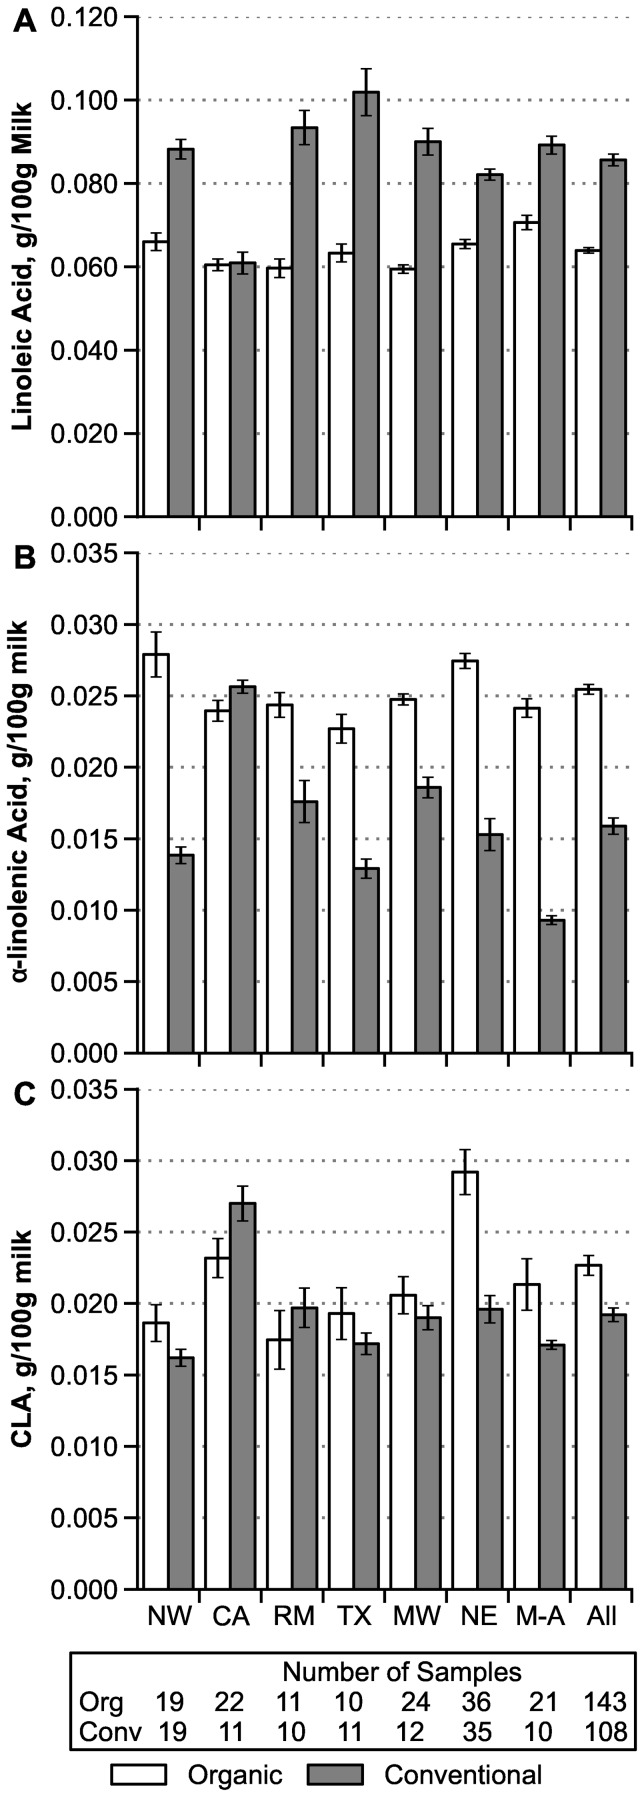
Regional variation in fatty acid content of retail whole milk, g/100 g (12-month average ± SE).
A: Linoleic acid (LA, ω-6). B: α-linolenic acid (ALA, ω-3). C: Conjugated linoleic acid. Abbreviations: NW  =  Northwest, CA  =  California, RM  =  Rocky Mountain, TX  =  Texas, MW  =  Midwest, NE  =  Northeast, M-A  =  mid-Atlantic. Numbers of samples apply to panels B and C; for panel A conventional NE is 34 and All is 107. For LA and ALA, all differences between organic and conventional contents are statistically significant by Mann-Whitney test (P<0.005) except for the CA region (P≥0.10). For CLA no such differences are statistically significant (P>0.08) except for the NE region and All regions (P<0.001).